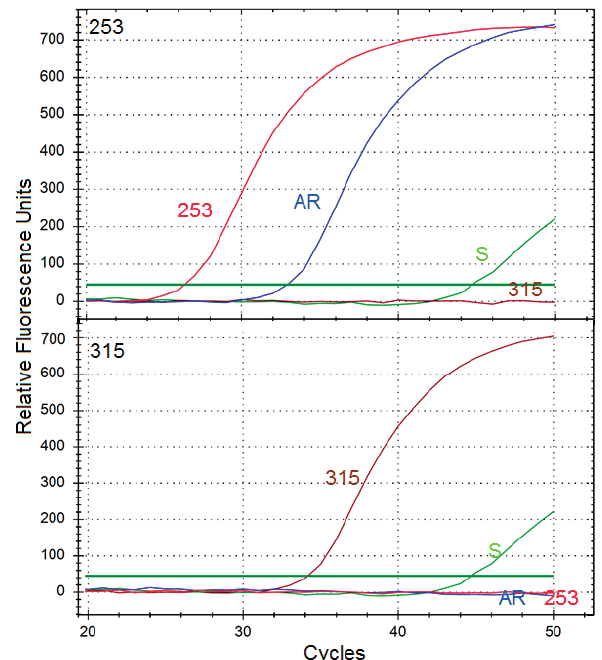
Figure 7. Results of a representative mutational analysis of BCR-ABL1-expressing cells: sensitive to imatinib (S) and primarily resistant to imatinib due to the Y253H with acquired resistance to imatinib. The analysis was based on an allele-specific RT-PCR with primers specific to cDNA obtained by reverse transcription of mRNA produced from the gene of active BCR-ABL1 kinase. The upper plot shows amplification with primers specific for the Y253H mutation, the lower shows those for the T315I mutation. Cell line harboring the T315I mutation (315) and cultured in the same conditions as 253 was used as a positive